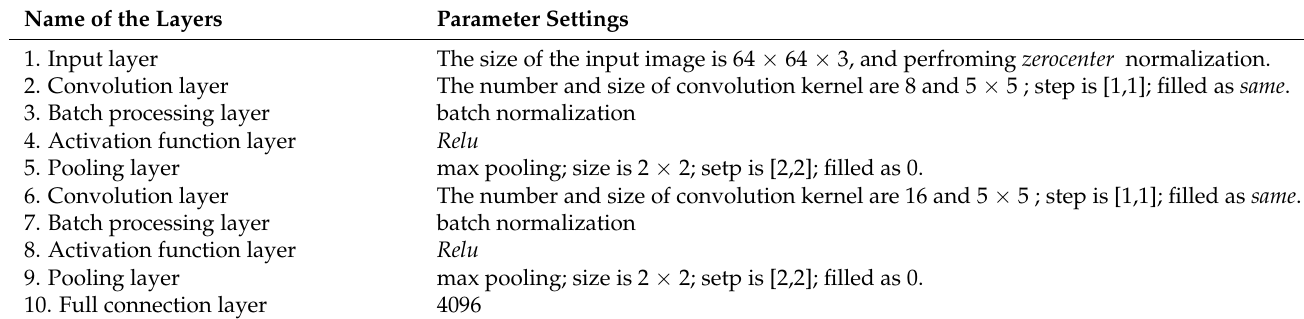
Table 1. 2D CNN Structure.